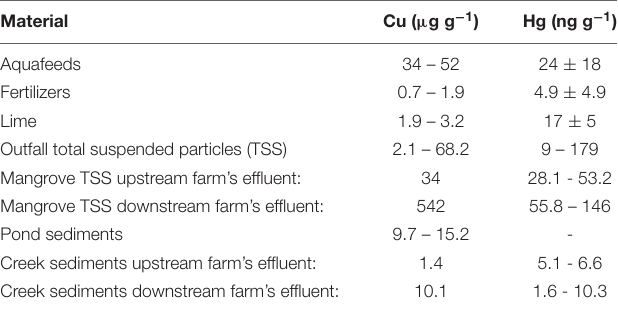
TABLE 2 | Concentrations of Hg and Cu in aquafeeds and chemicals used in intensive shrimp farms in Northeast Brazil and environmental levels in local mangroves, from Lacerda et al. (2006a), Lacerda et al. (2011), Costa et al.